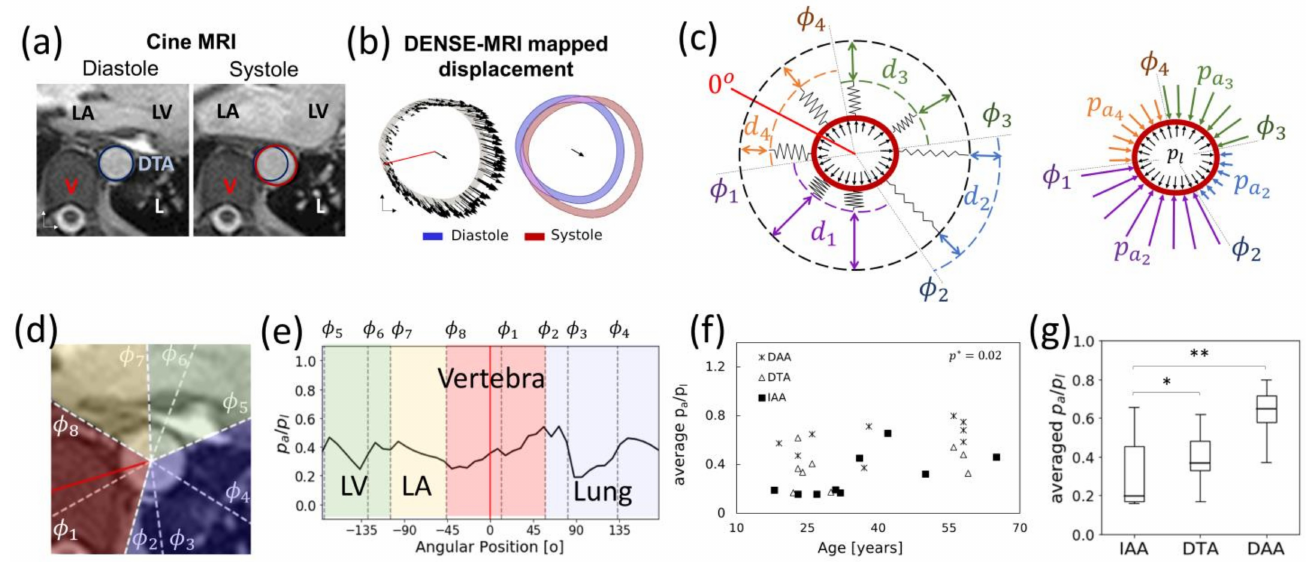
Figure 13. Inverse analysis of perivascular interactions at the descending thoracic aorta (DTA), based on results from Bracamonte et al., 2021 [150]. ( a ) Surroundings of the DTA. ( b ) DENSE MRI-derived displacement quiver representation and mapping into deformed (systolic) configuration. ( c ) Moving elastic foundation implementation and equivalent adventitial load distribution. ( d ) Patient-specific elastic boundary, and ( e ) adventitial load distribution. ( f ) Adventitial load increments with age. ( g ) Average adventitial load at different aortic locations (* p -value < 0.05; ** p -value < 0.01). Symbols: φ elastic boundary region angular delimiter, d moving elastic boundary displacement, p a adventitial force per unit area, p l luminal pressure increment, LA left atrium, LV left ventricle, V vertebra, L lung, IAA Infrarenal abdominal aorta, DTA descending thoracic aorta, DAA distal aortic arch. Red line (0 ◦ ) is the angular reference selected as the closest location of the vertebra to the aortic